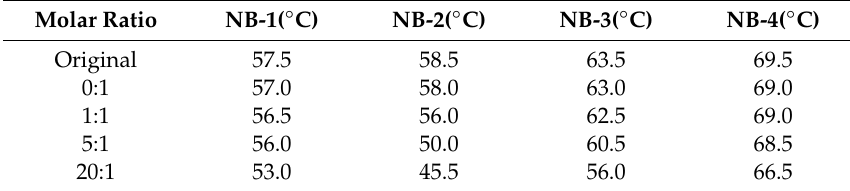
Figure 6. Labeled NB-1 stained beads visualized by laser scanning confocal microscope. A and B were β 2m coated beads, C and D were BSA coated beads, A and C were bright field images, and B and D were merged images, E was the schematic diagram of VHHs modified by NHS-Fluo.